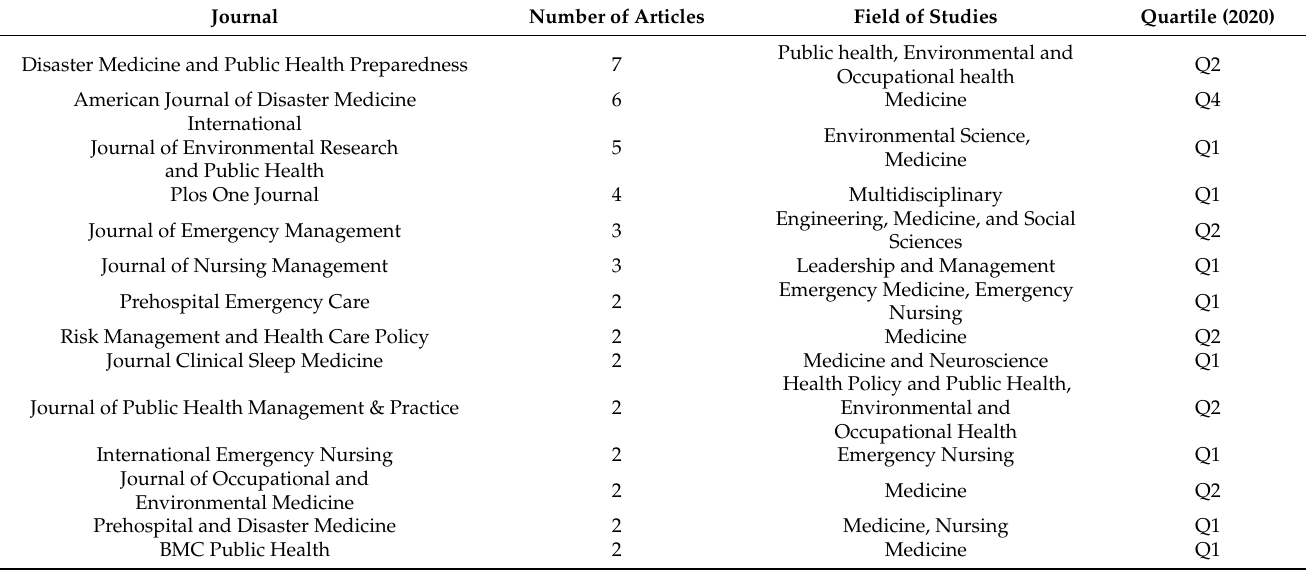
Table 3. Scientific journal